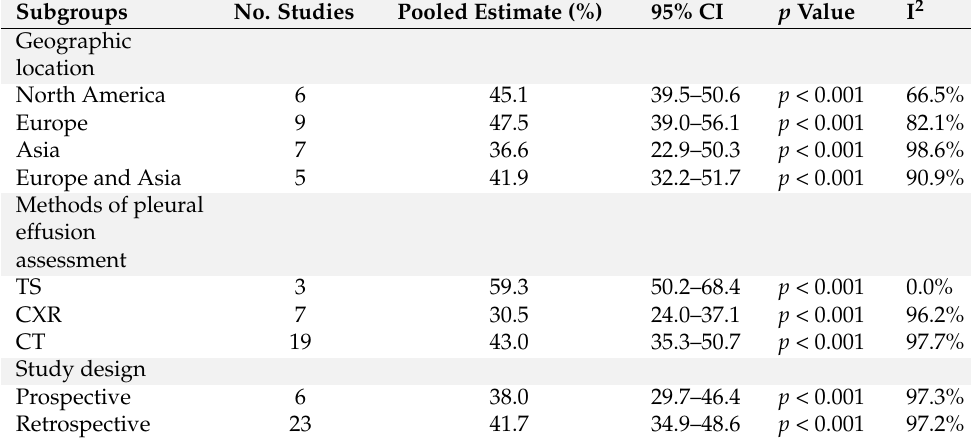
Table 2. Subgroup analyses regarding risk of pleural